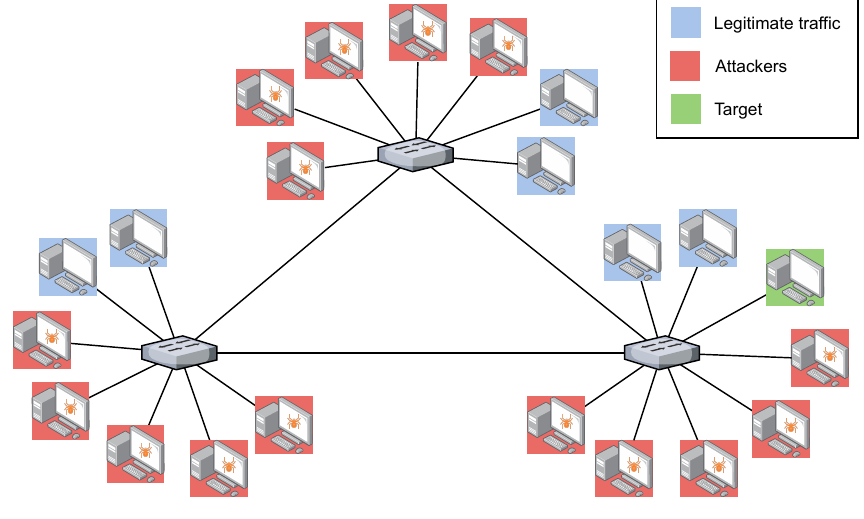
Figure 10. Test bed topology of the third scenario. Adapted from [16]. Table 3. Results of experimentation with IoT traffic for different window and θ